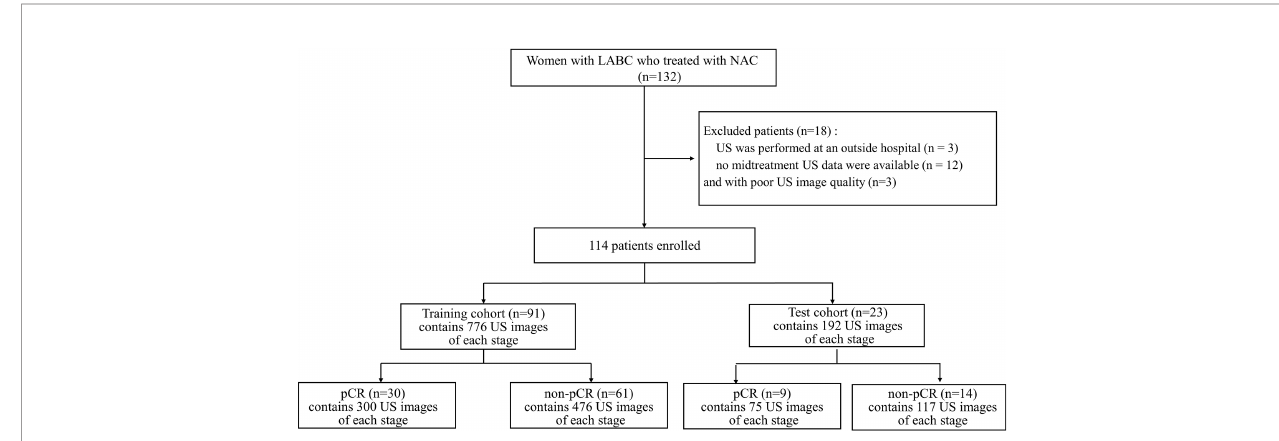
FIGURE 1 | Flowchart for the study. LABC, Locally Advanced Breast Cancer; NAC, Neoadjuvant Chemotherapy; US, Ultrasound; pCR, Pathologic Complete Response; non-pCR, non-Pathologic Complete